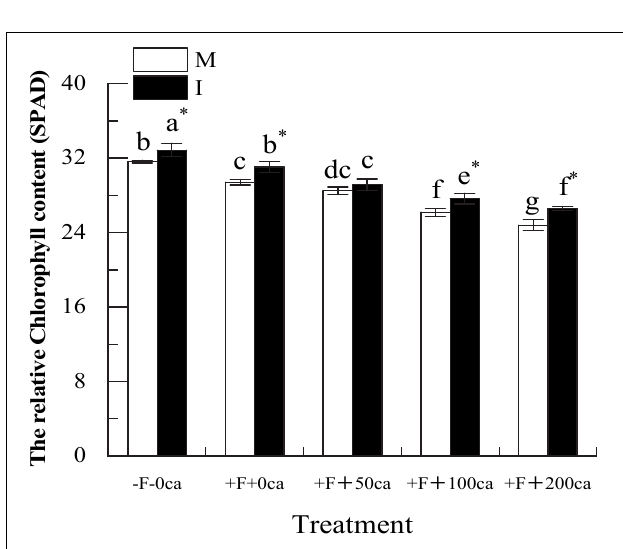
FIGURE 7 | Effects of FOF and cinnamic acid stress on the relative chlorophyll content of faba bean leaves and the intercropping effect. Values in the table are mean ± standard error. Different lowercase letters after data indicate significant difference ( P < 0.05). ∗ Significant differences between monocropping and intercropping treatments with the same FOF and cinnamic acid levels ( P < 0.05). ca, cinnamic acid; FOF, Fusarium oxysporum f. sp. fabae ; I, intercropping: M,